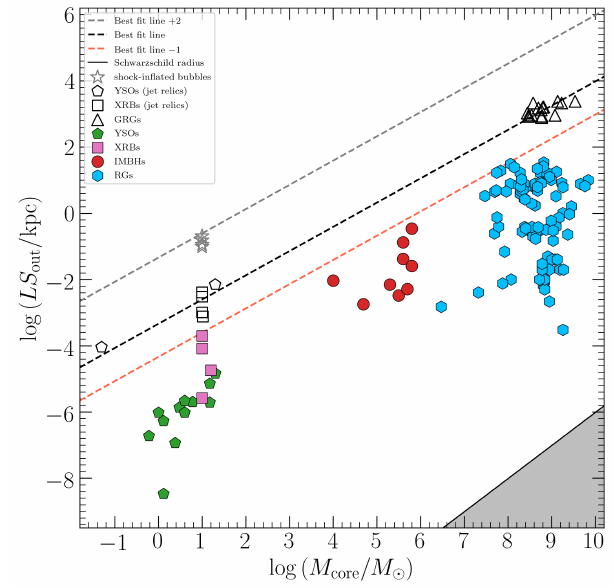
Figure 3. The linear size of outflow distribution along the masses of